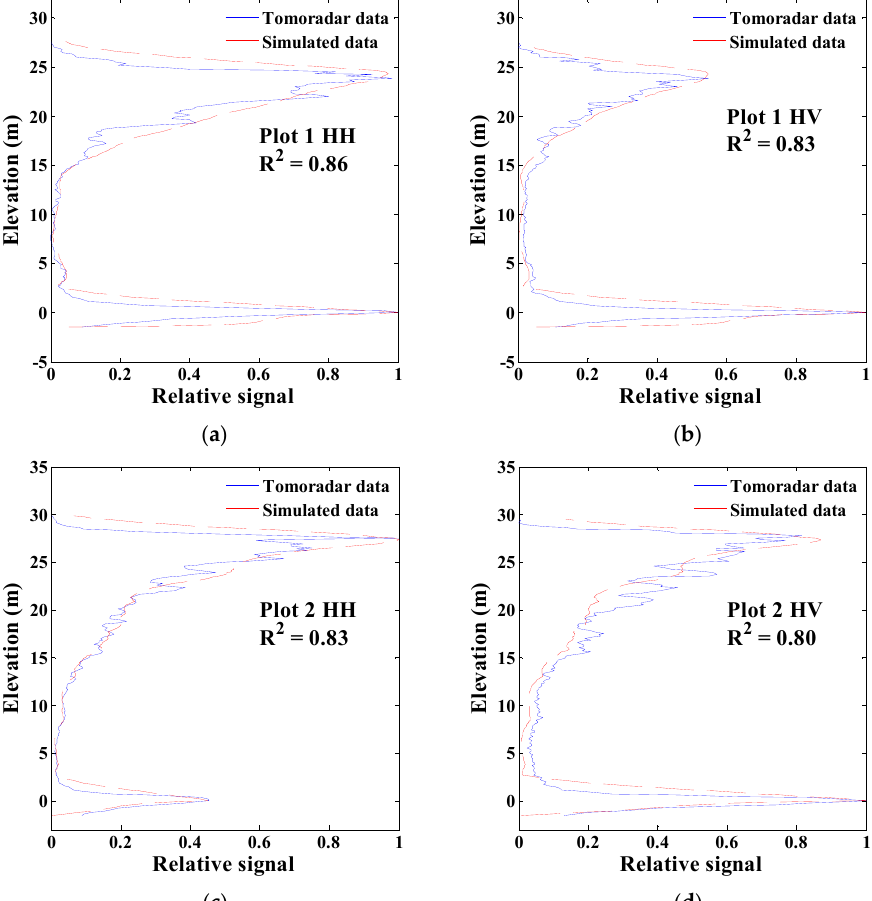
Figure 9. Comparison between the average waveforms of simulated data (red dashed line) and Tomoradar data (blue solid line): ( a ) HH polarization of plot 1 (R 2 = 0.86); ( b ) HV polarization of plot 1 (R 2 = 0.83); ( c ) HH polarization of plot 2 (R 2 = 0.83); ( d ) HV polarization of plot 2 (R 2 = 0.80).